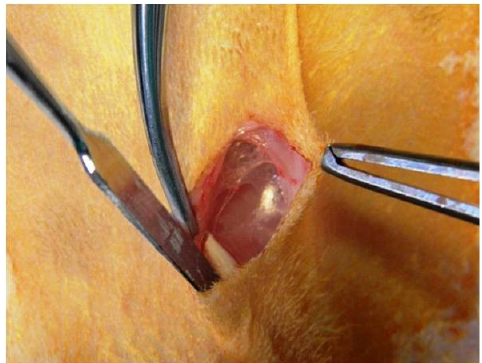
Figure 1. Subcutaneous technique for implantation of biomaterials. Tubes were inserted as deep as the created tissue pocket allowed. In the end, the surgical wound was sutured with non-absorbable suture thread (Figure 2).